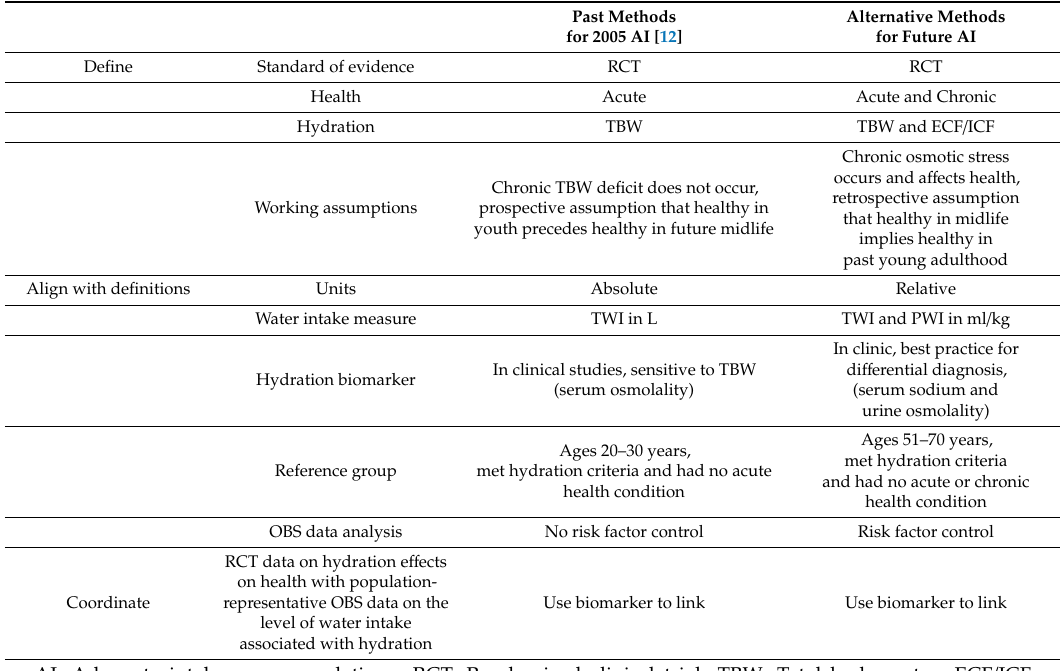
Table 1. Definition, alignment, and coordination of evidence to inform the 2005 Adequate Intake recommendation for water and possible alternative methods for future